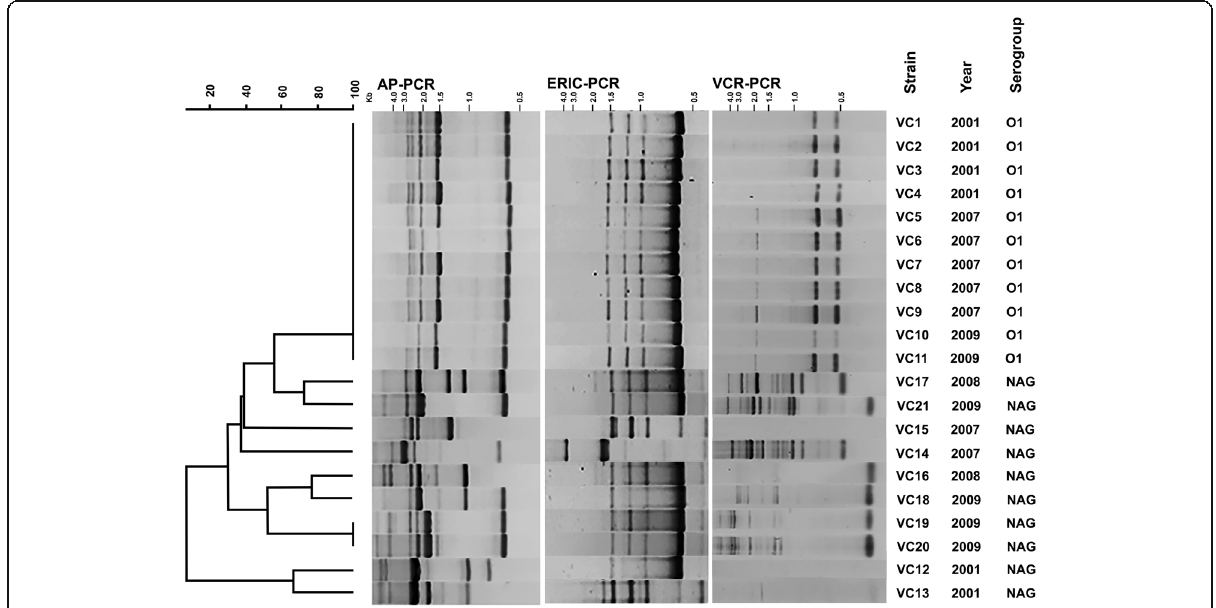
Fig. 1 Dendrogram and PCR fingerprints for comparison of V. cholerae isolates. The dendrogram is based on the PCR fingerprints generated by AP-PCR. The PCR fingerprints of ERIC-PCR and VCR-PCR are provided for direct comparison